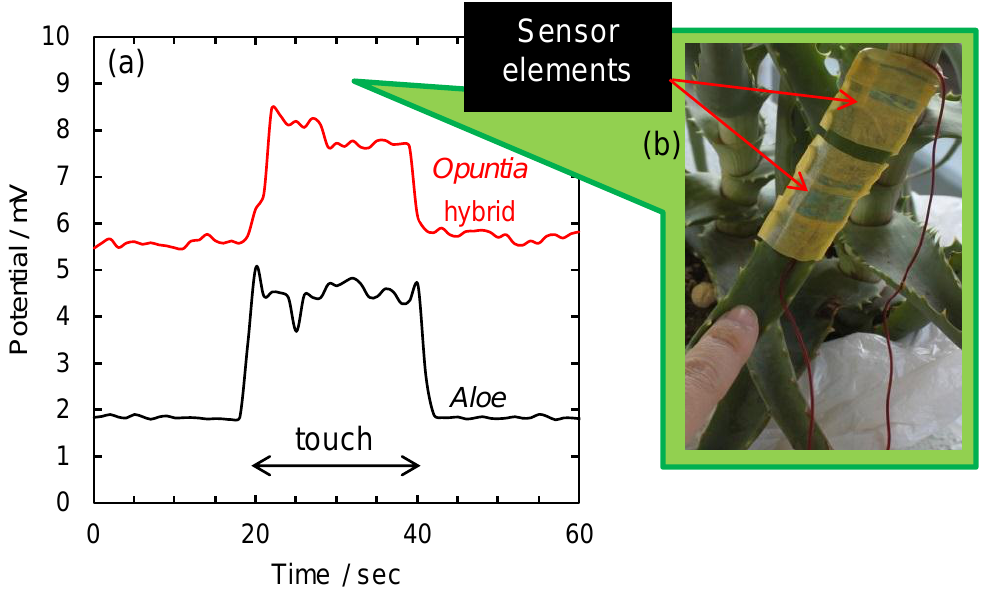
Figure 3. ( a ) Potential changes between a pair of BDD plate electrodes on potted Aloe and Opuntia hybrid for a finger touch lasting 20 s. ( b ) Image showing finger touch on a leaf of the potted Aloe.